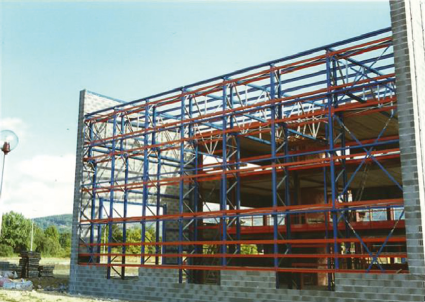
Figure 3: Structural system of self-supporting shelves for the construction of a